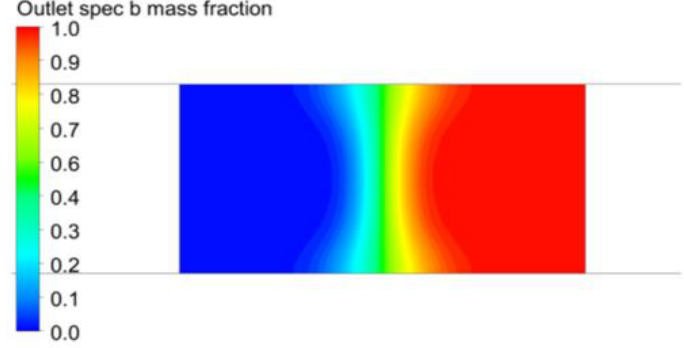
Figure 5. Mass fraction contour at outlet of T-mixer at Re = 66